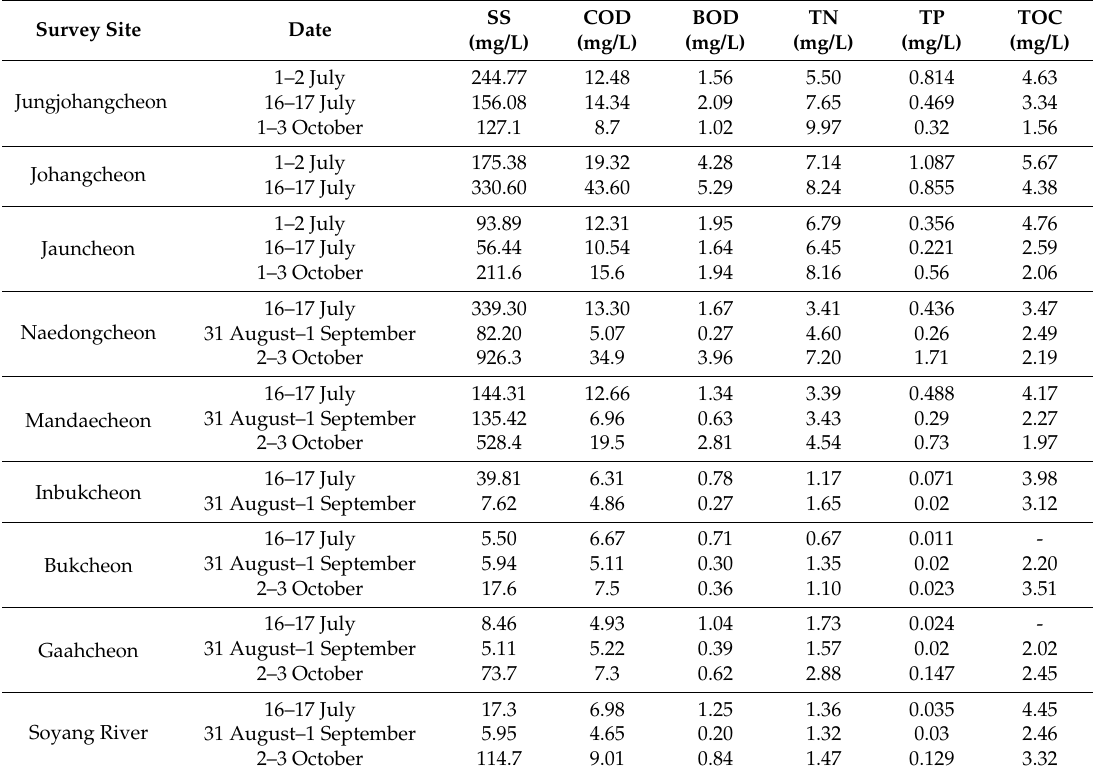
Table 6. EMC of each rainfall event in the Lake Soyang